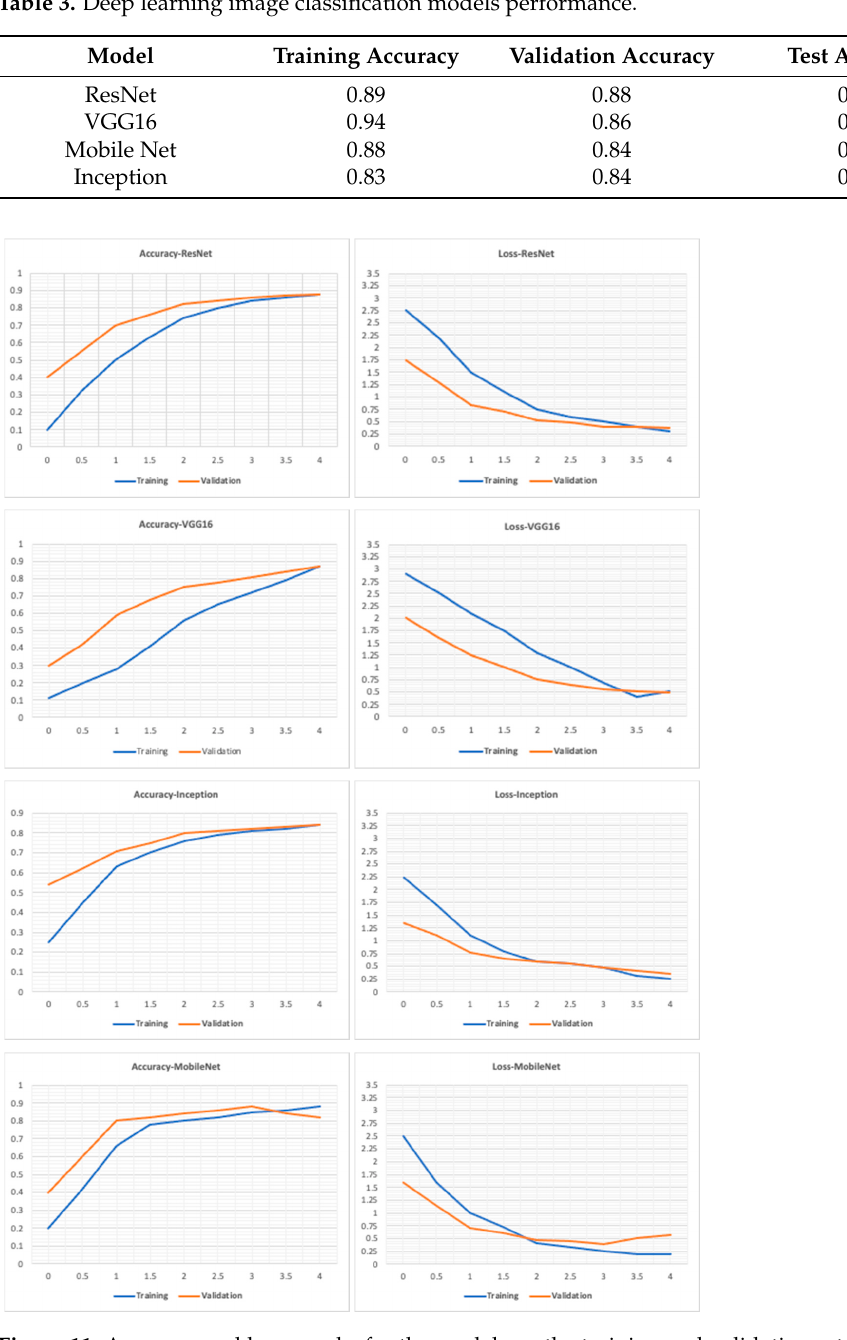
Figure 11. Accuracy and loss graphs for the models on the training and validation sets. Table 3. Deep learning image classification models performance.